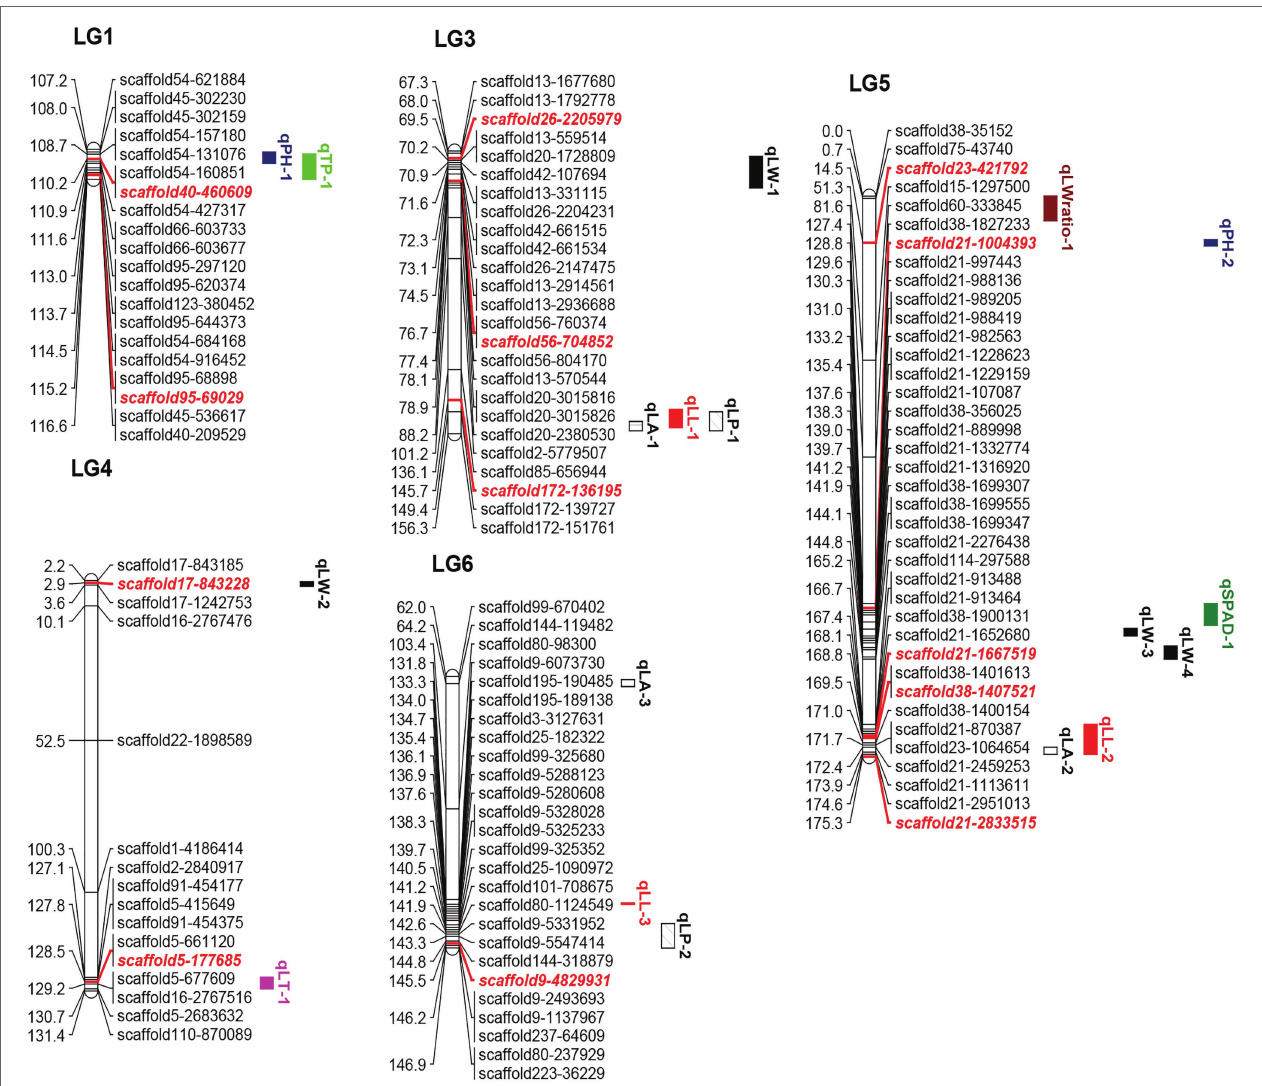
FIGURE 1 | Quantitative trait loci locations on the linkage map. The red and italicized loci correspond to SNPs validated in KASP experiments. LL, leaf length; LW, leaf width; LA, leaf area; LW ratio, LL/LW; LP, leaf perimeter; TP, trunk perimeter; LT, leaf thickness; SPAD, chlorophyll content; and PH, plant